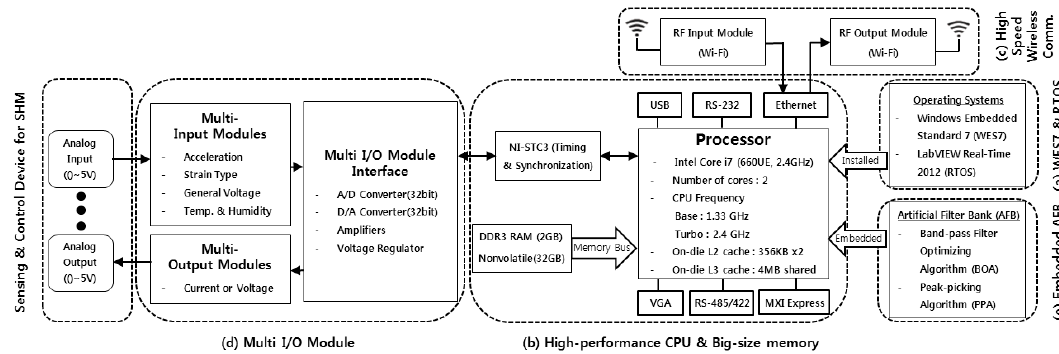
Figure 1. Design of the IDAQ system.